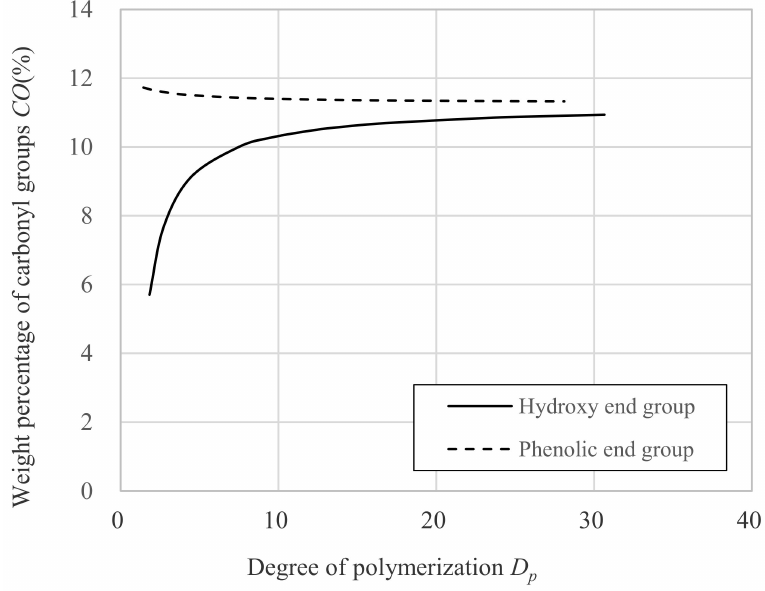
Figure 4. Relation between degree of polymerization D p and the weight percentage of carbonyl groups